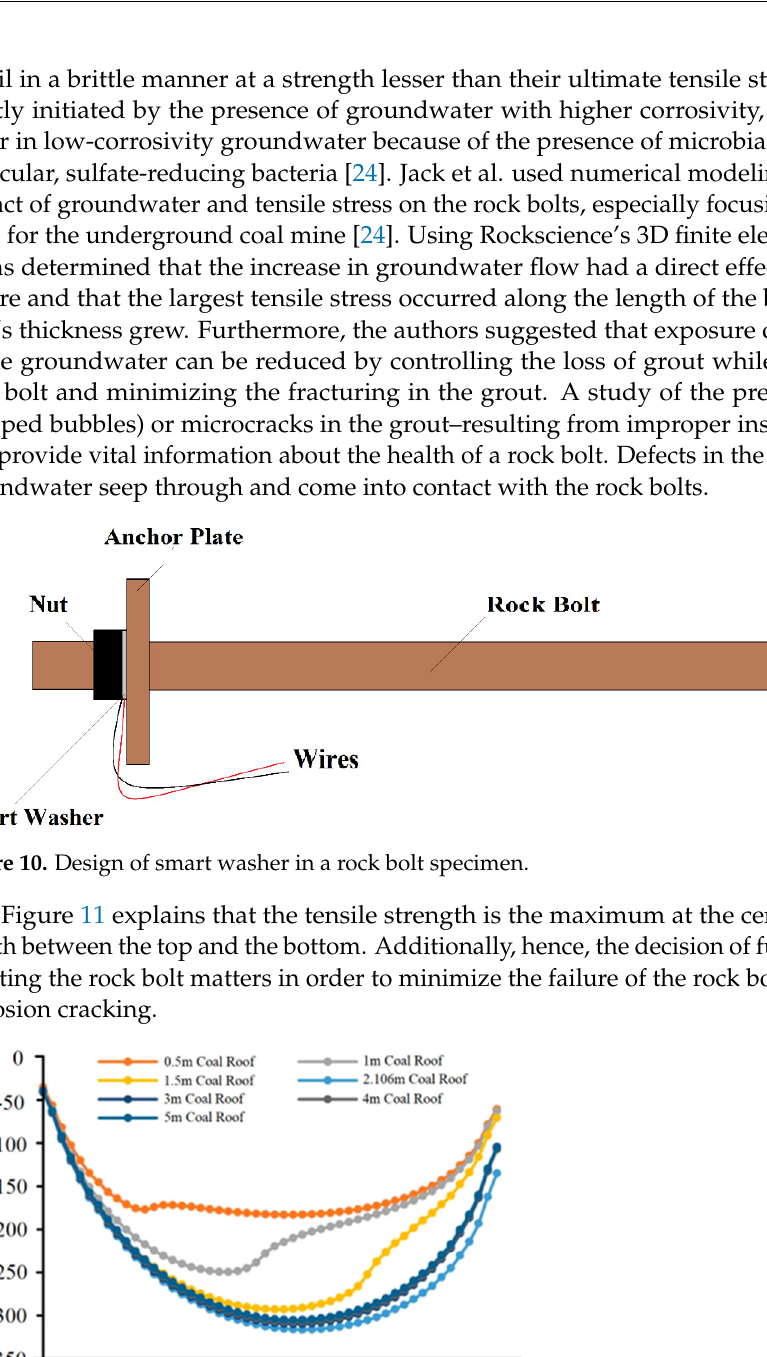
Figure 9. Brillouin Frequency shift [21].